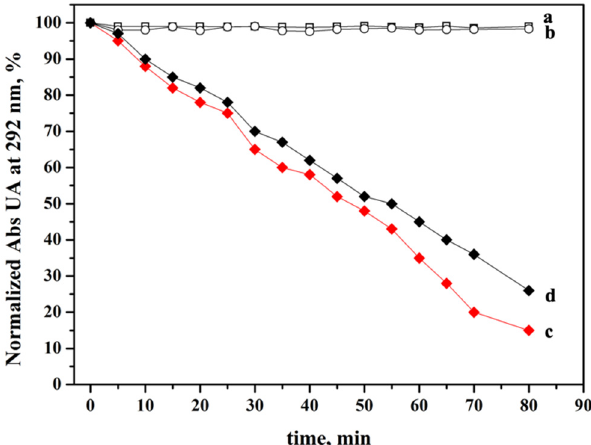
Figure 7. ( A ). UC emission spectra of ZEY2 (curve a, red) and ZEY2@SiO 2 (curve b, black); ( B ). Normalized UC emission spectra of ZEY2 (red curve), ZEY2@SiO 2 (black curve), and ZEY2-Ver (green curve).